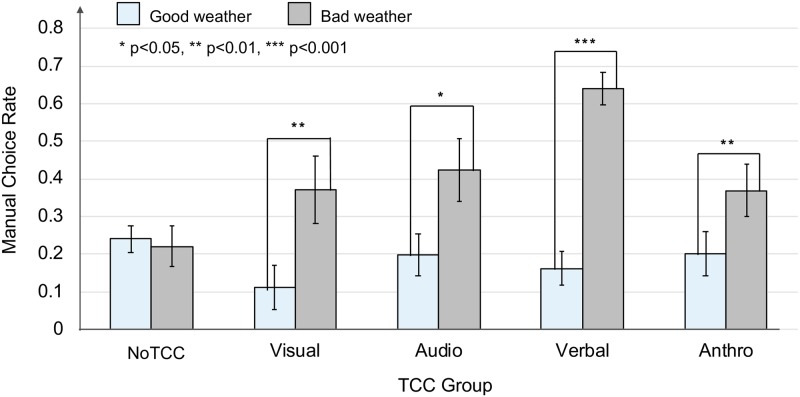
Manual rates over time.